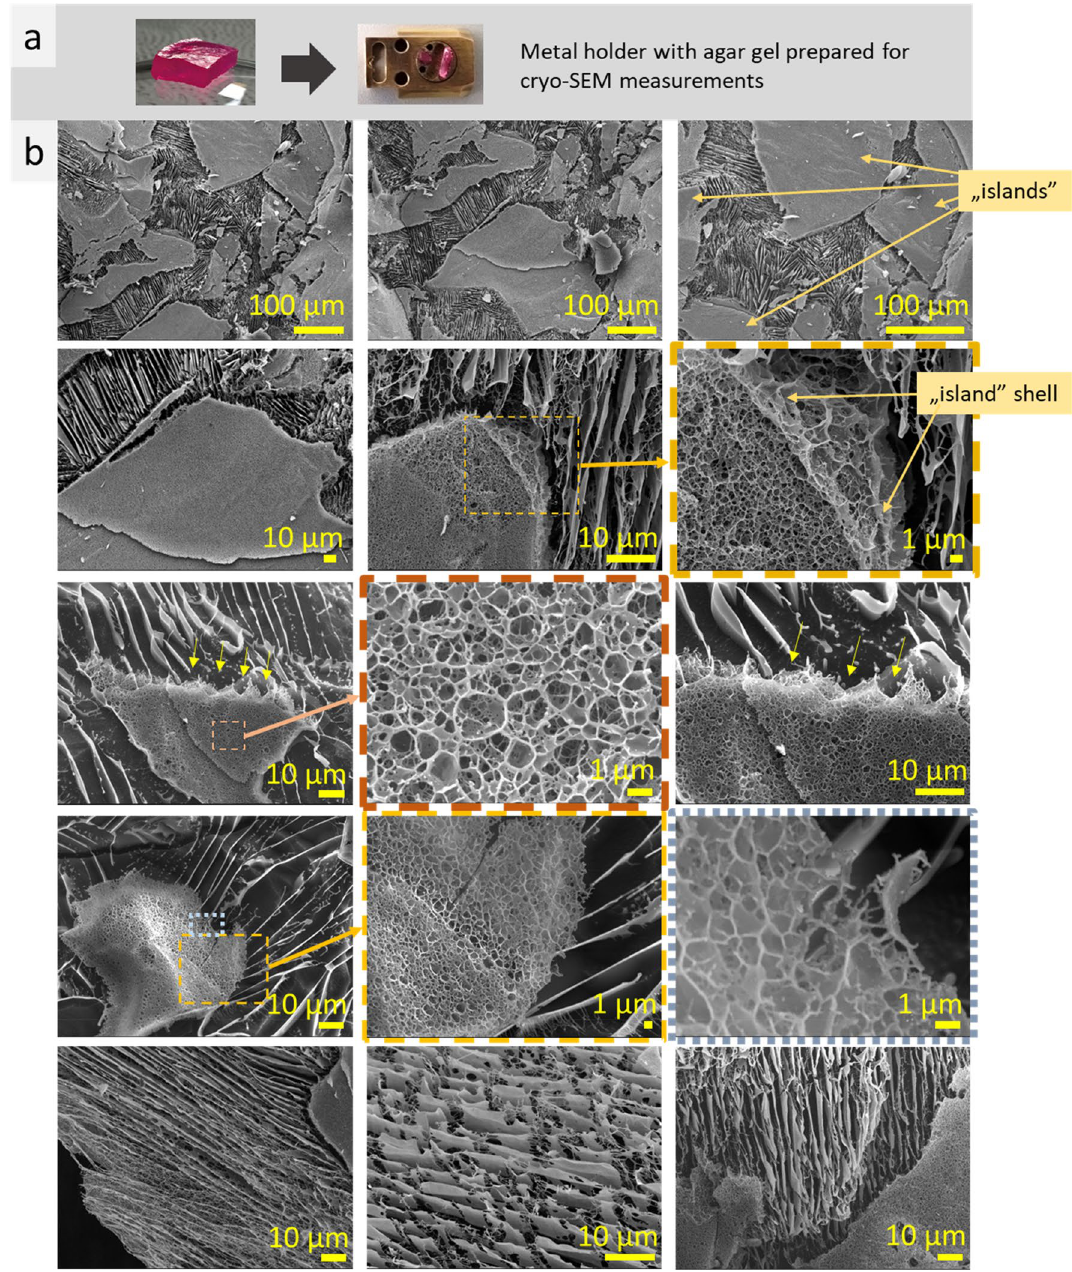
Figure 1. Photos of a piece of agar gel with rhodamine B and specimen shuttle with 10 mm aluminum holder with the gel prepared for cryo-SEM measurements ( a ); cryo-SEM images of agar gel with rhodamine B ( b